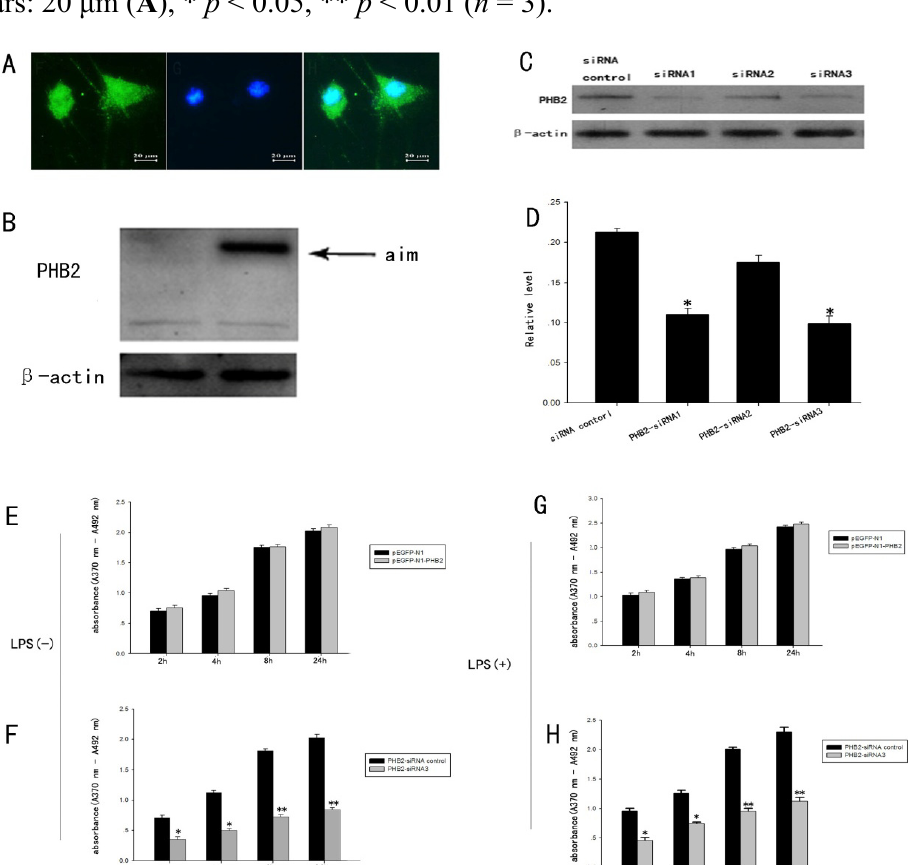
Figure 5. The influence of proliferation of primary cultured astrocytes induced by LPS confirmed by BrdU ELISA detection technology. Immunofluorescence showed that PHB2 localized in both cytoplasm and nucleus of primary cultured astrocytes ( A ); Western Blot results showed that, there was a band at the anticipated size (the size of fusion protein) position on the cellulose acetate membrane after transfection with pEGFP-N1-PHB2 ( B ); but not transfection with pEGFP-N1. As shown by Western Blot analysis, siRNA3 made a significant effect in reducing PHB2 expression ( C , D ); BrdU ELISA results show that proliferation of astrocytes, induced by LPS ( G , H ); was higher than that in the control group ( E , F ); ( E , G ) showed that the proliferation of astrocytes which over-expressed PHB2 was slightly higher than that in the control group, but there was no significant difference; ( F , H ) Cell proliferation was inhibited after the PHB2 was interfered with in astrocytes, resulted in a significant difference from the control group. Error bars represent SEM, Scale bars: 20 μ m ( A ), * p < 0.05, ** p < 0.01 ( n =